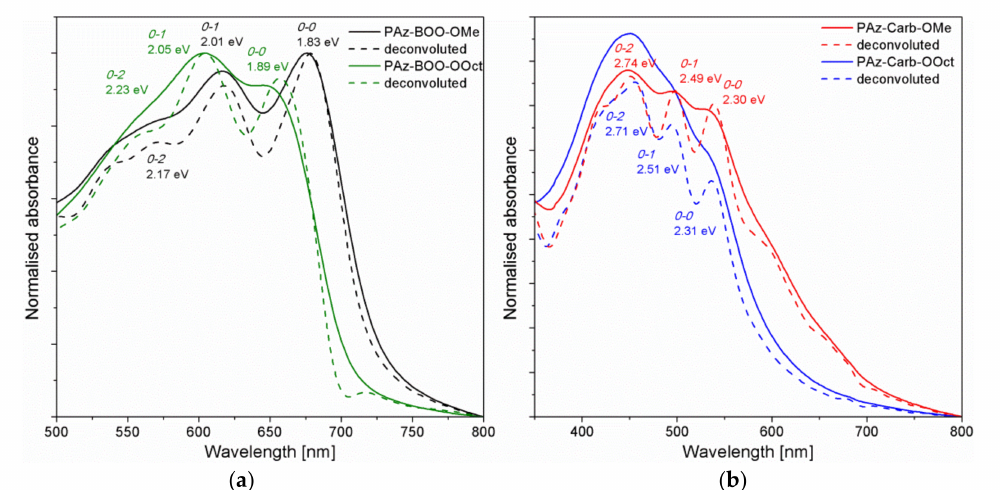
Figure 5. Normalized (solid line) and deconvoluted (dashed line) spectra of PAz-BOO ( a ) and Paz-Carb ( b ) imine thin